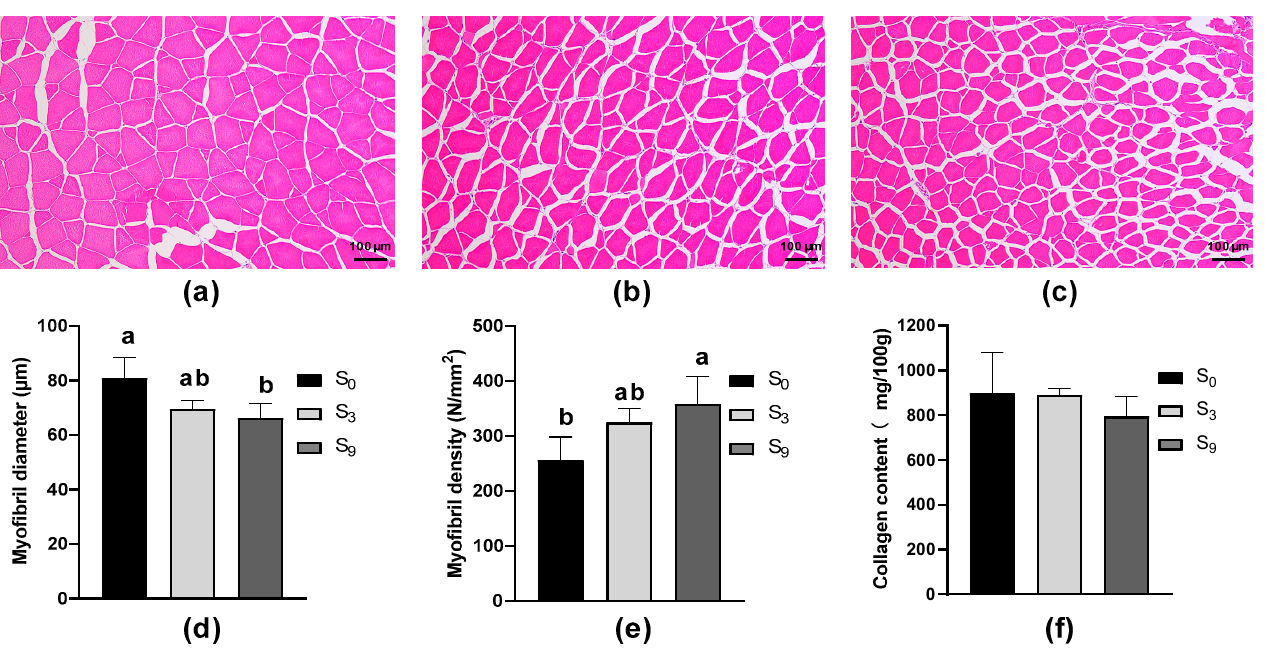
Figure 2. Effect of salinity on myofibril structure and collagen content of largemouth bass muscle. ( a ) Muscle histology sections of S 0 group; ( b ) muscle histology sections of S 3 group; ( c ) muscle histology sections of S 9 group; ( d ) diameter of myofibers ( µ m) ( n = 30, random 10 myofibers of every section, three sections of every group); ( e ) density of myofibers (N/mm 2 ) ( n = 30, random 10 myofiber of every section, three sections of every group); ( f ) collagen content in muscle ( n = 3). All histology sections were photographed under 100× magnification. Bars with different letters (a, b) are significantly different ( p < 0.05; Tukey’s test) between the two groups.